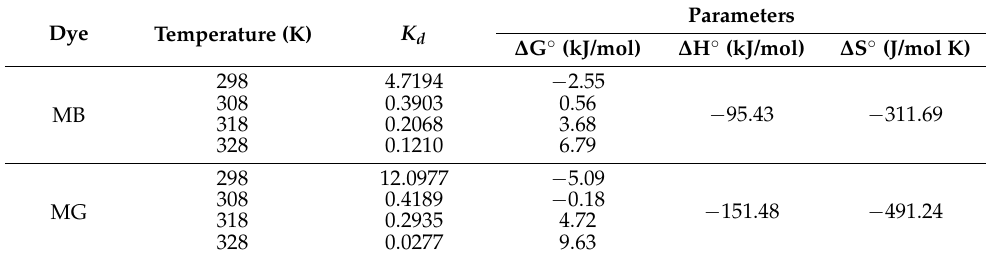
Table 5. The thermodynamic parameters for MB and MG